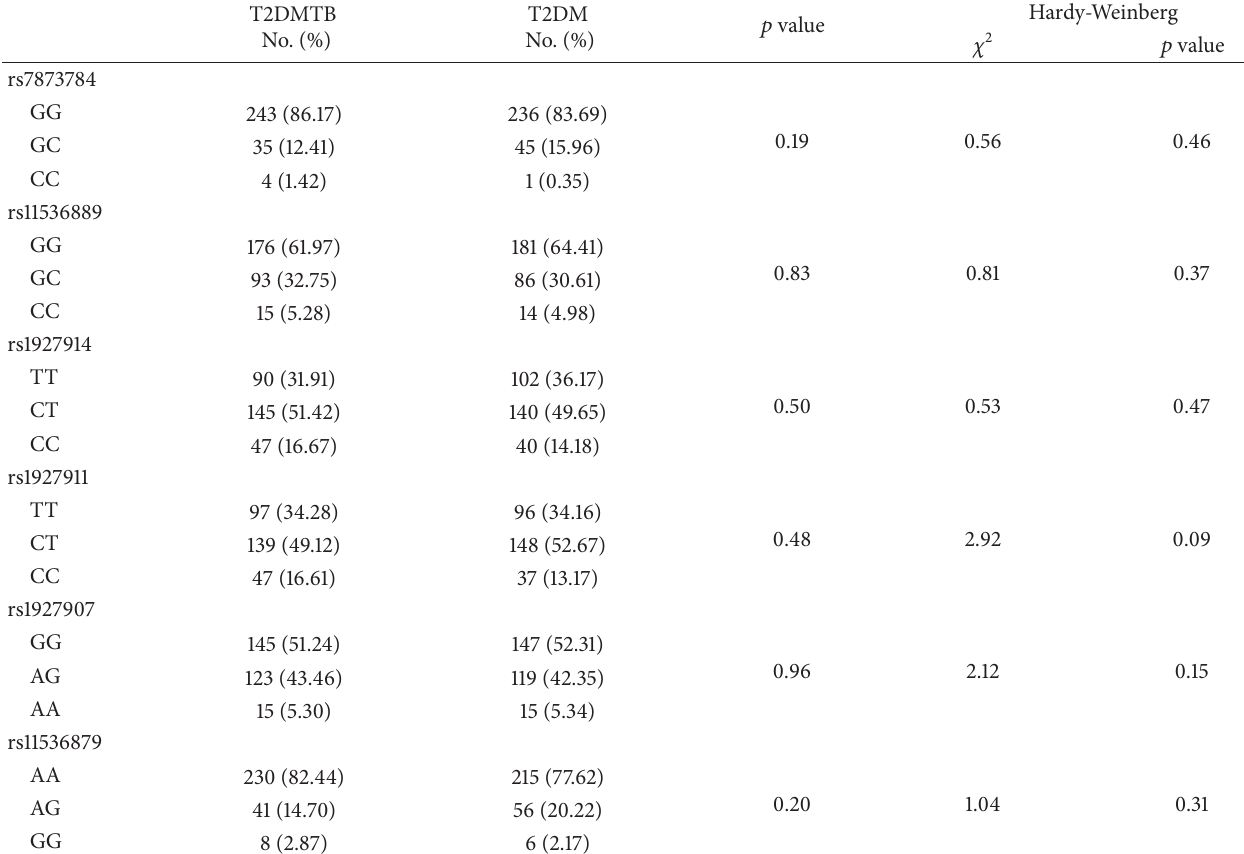
Table 3: Distributions of SNP genotypes and Hardy-Weinberg equilibrium.